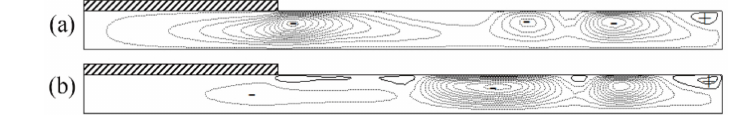
Figure 15. Distributions of local capillary ratios along the free surface for the cases shown in Figure 14.